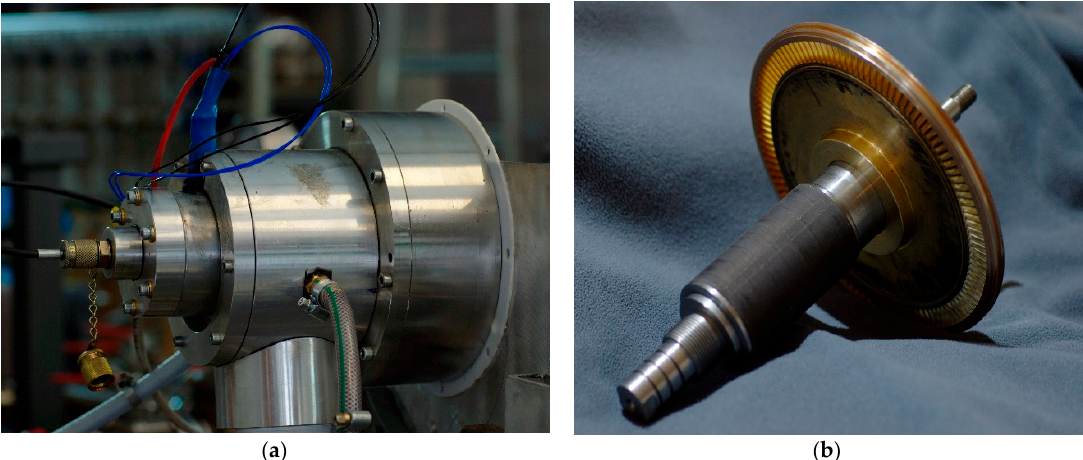
Figure 17. Example of experimental single stage micro turbine. (a) view of experimental micro turbine; (b) bladed rotor of micro turbine with shaft and electrical generator rotor.